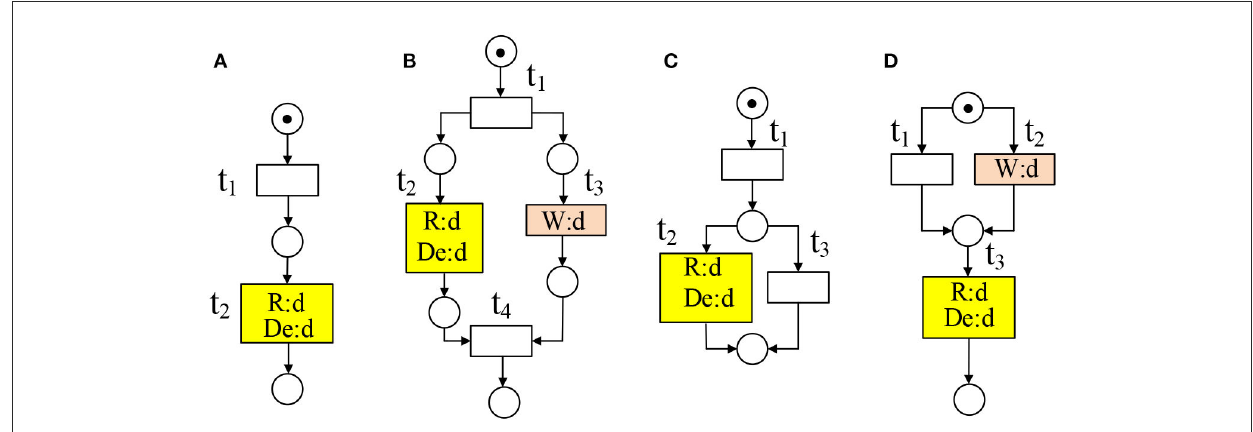
FIGURE3 d is a missing data in (A–D)